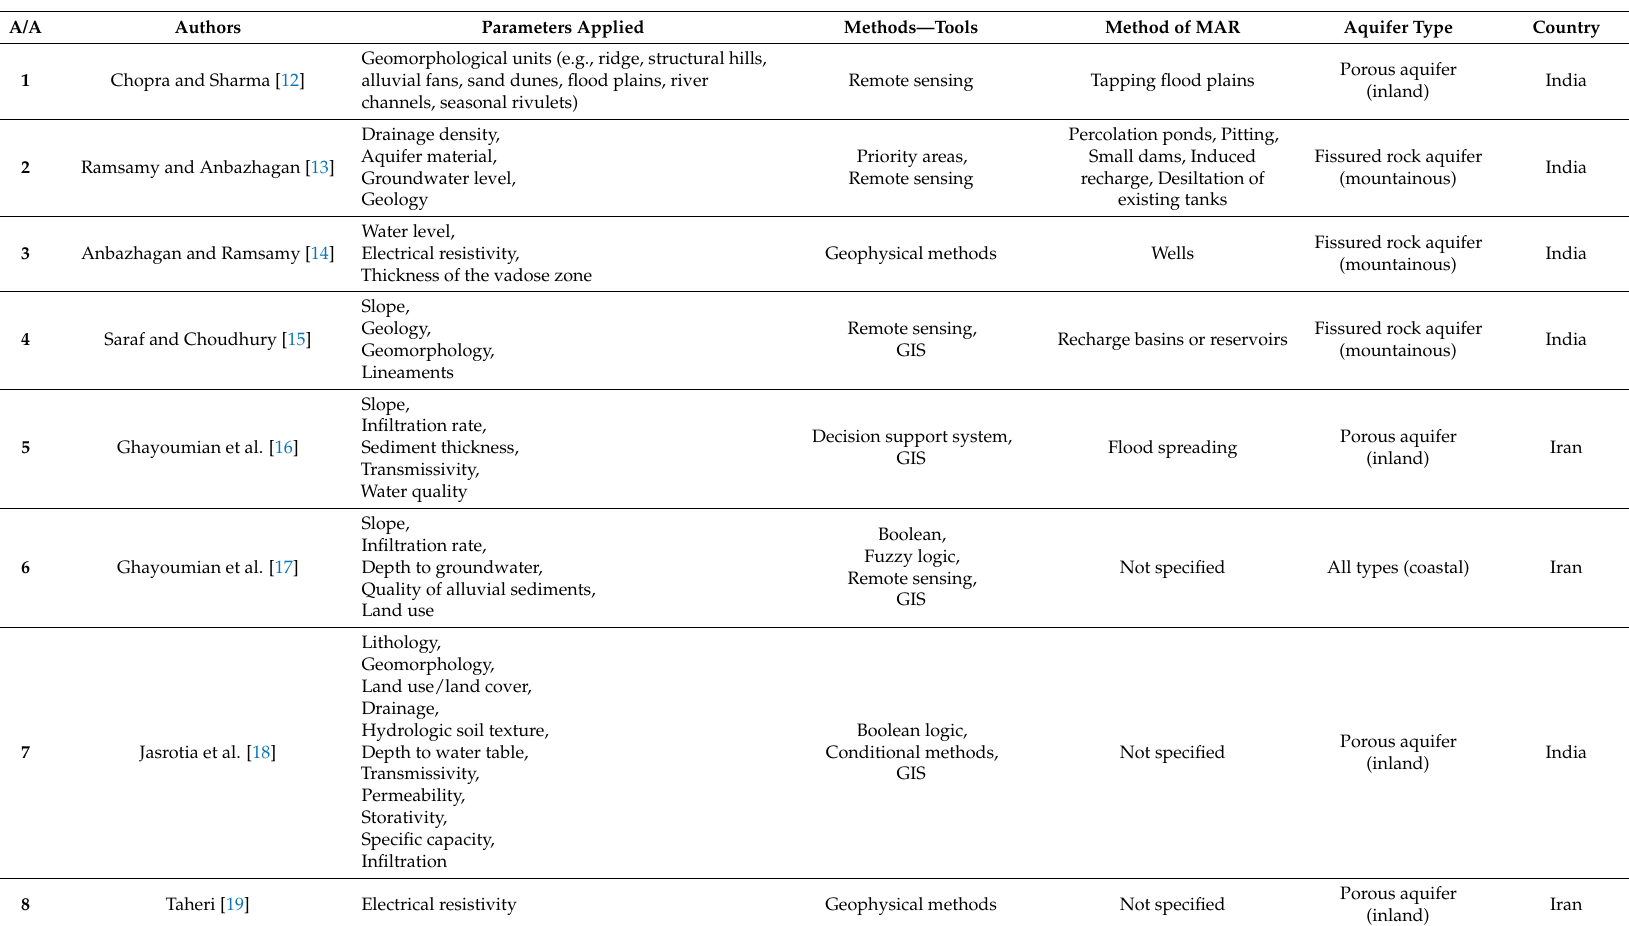
Table 1. Summarized literature review of available research articles on MAR site